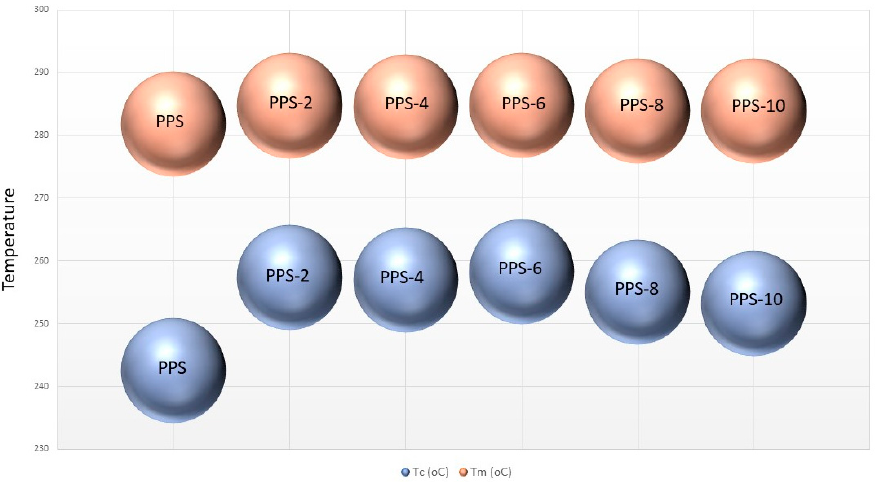
Figure 10. Comparative illustration of T c and T m of PPS@BC nanocomposites. From the DSC trace of the cooling cycle, it is evident that the crystallization process of the PPS was accelerated by the addition of the filler, as there was a narrowing of the crystallization peak. The degree of supercooling ( ∆ T) in the Figure 11 shows a decrease in value compared with that required for the neat PPS. So, crystallization in the nanocompos- ites is higher as compared to that required for neat PPS. The drop in value of the degree of supercooling indicated that the nucleation process was enhanced due to the presence of the BC nanofiller.